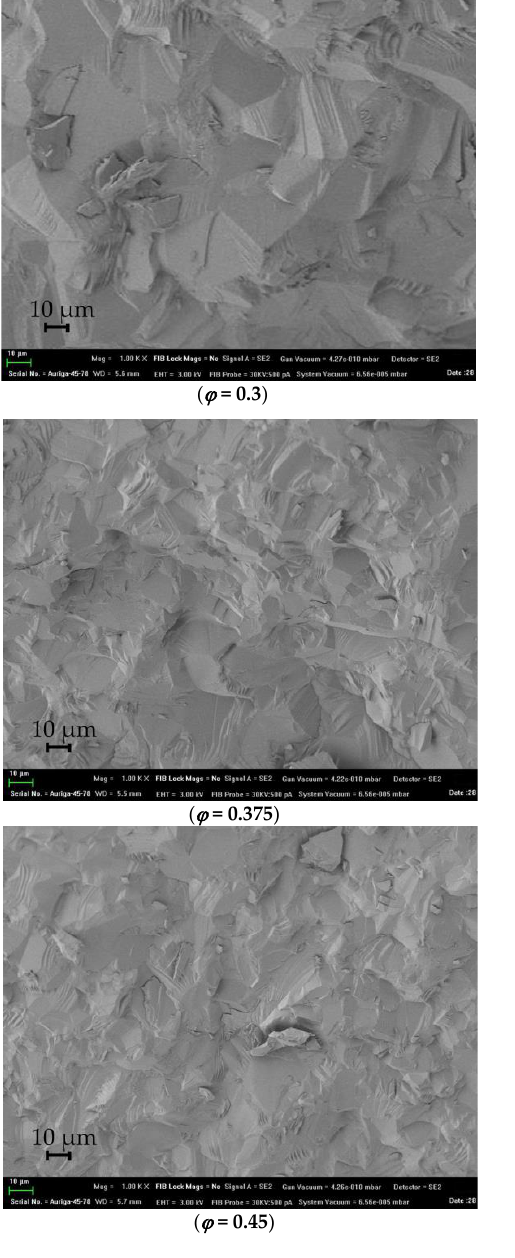
Figure 6. SEM micrographs of Y 2 O 3 ceramic fractures with different SHS precursor compositions  and 1wt.% LiF sintering additive. and 1 wt. % LiF sintering